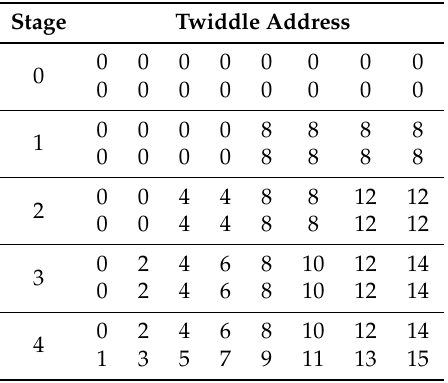
Table 2. Phase factor addressing scheme example ( N = 32 and β = 2).